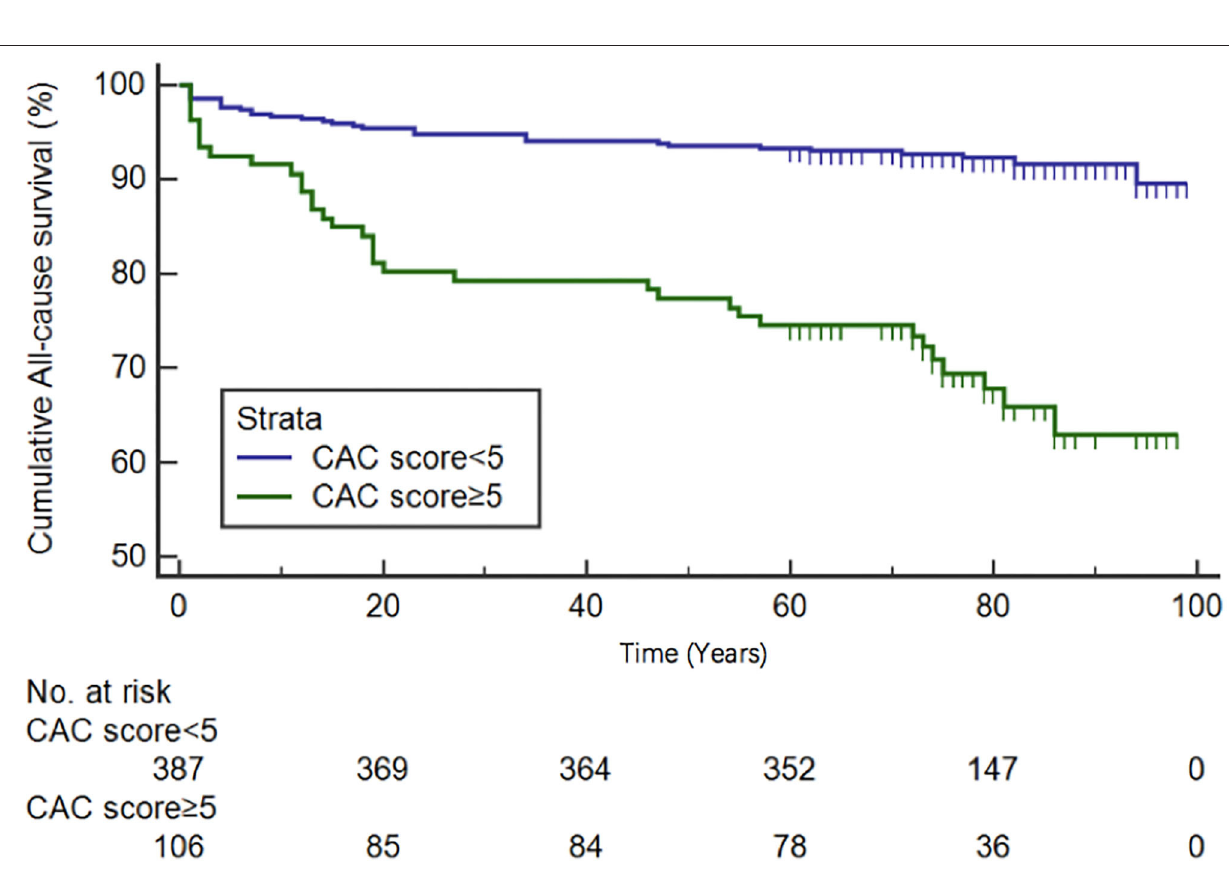
Frontiers in Cardiovascular Medicine |